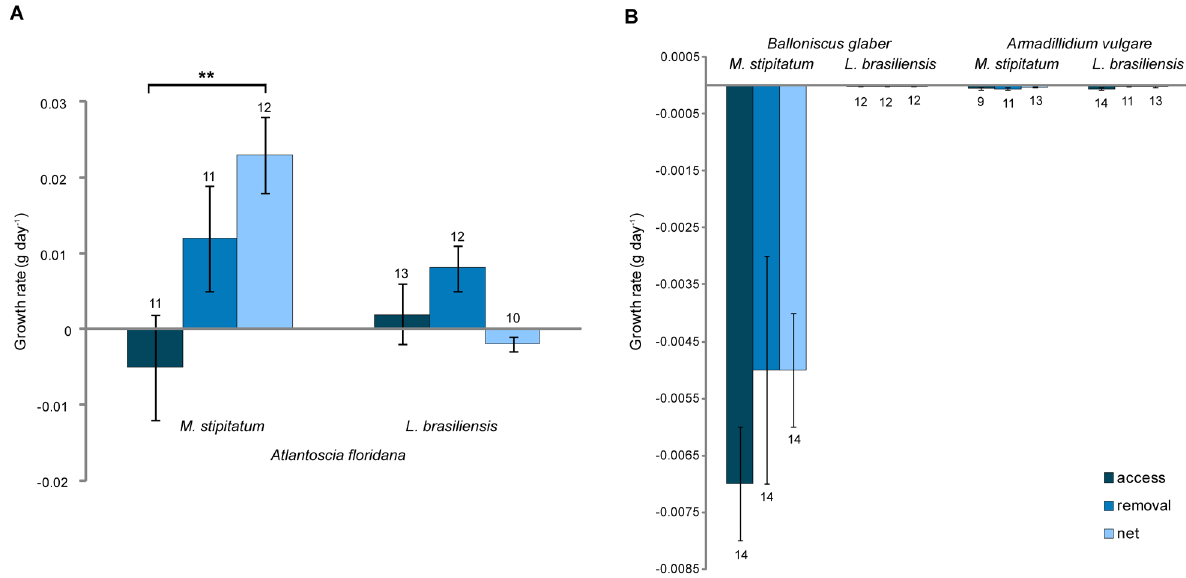
Figure 4. Growth rate of isopods in three different treatments. A. Growth rate of Atlantoscia floridana . B. Growth rate of Balloniscus glaber and Armadillidium vulgare . The values are mean ± SE and the numbers on top indicate the sample number for each index.